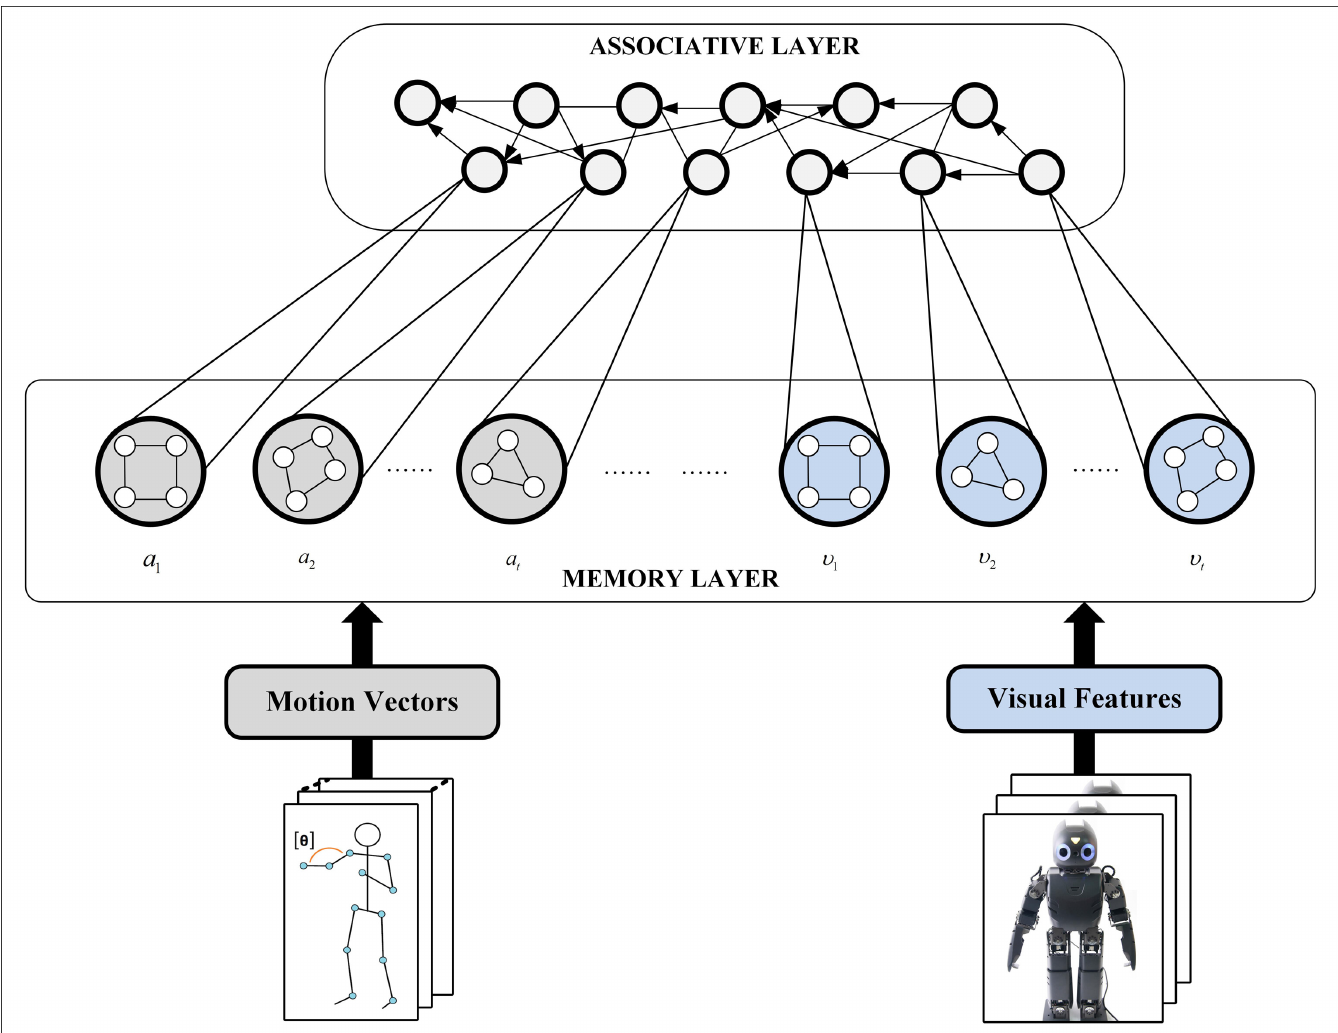
Fig 6. Associative Memory